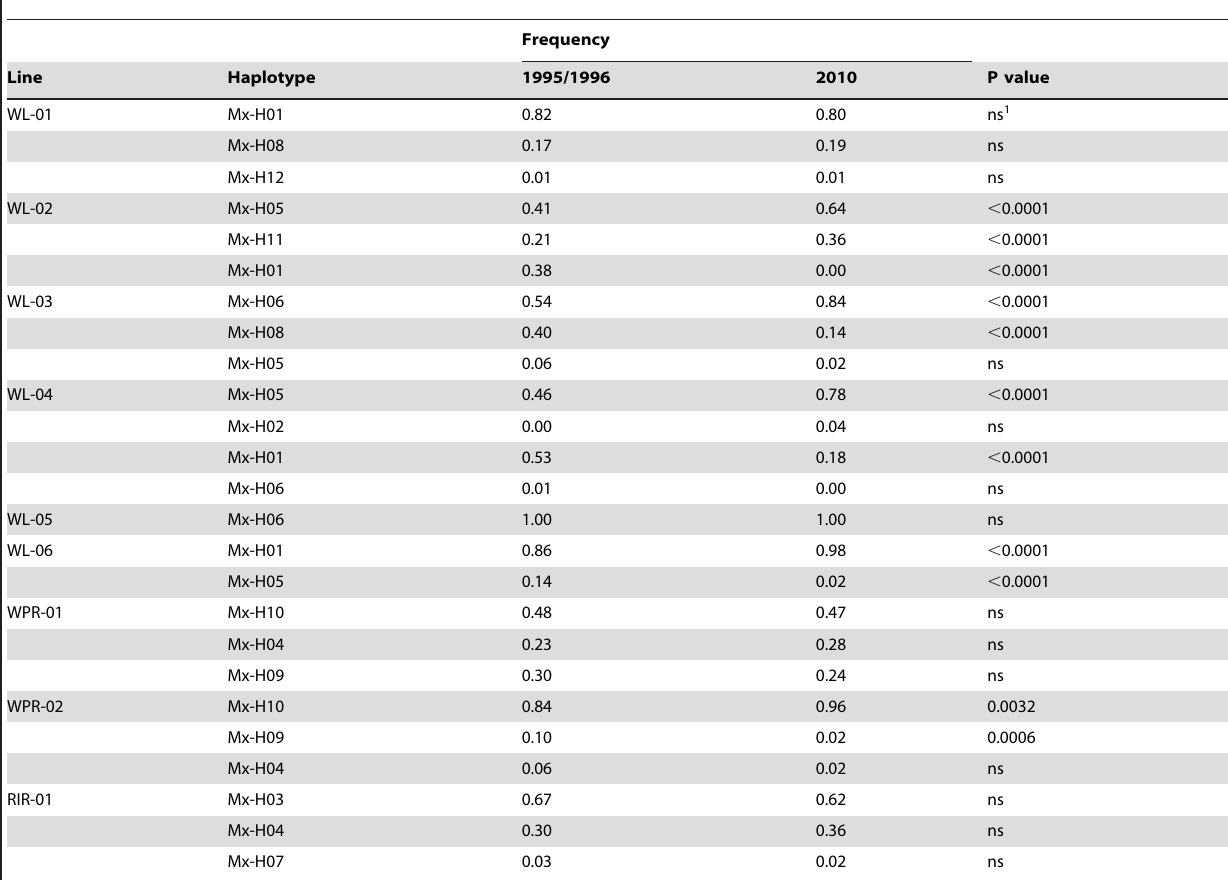
Table 4. Mx haplotype frequency changes over time by